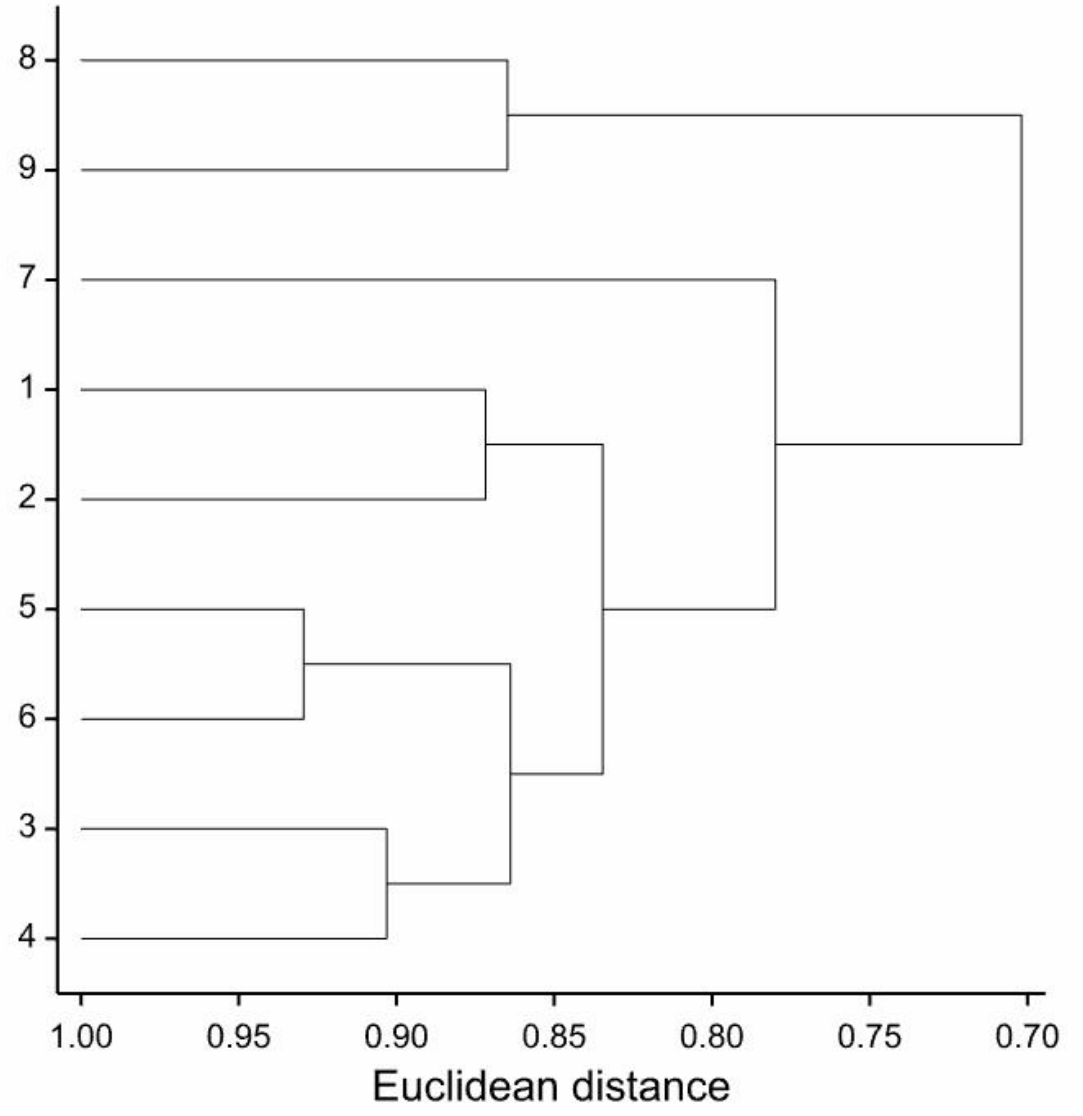
Figure 4. Dendrogram of cluster groupings of nine combinations based on all 19 quantitative traits.